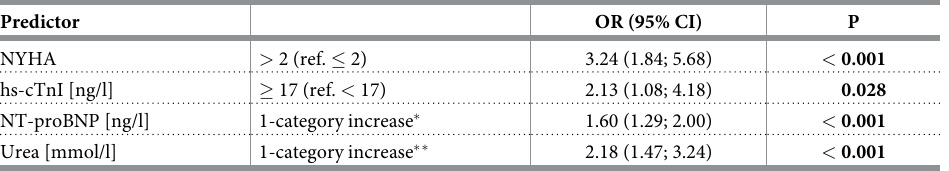
Table 4. The multivariable logistic regression model using a backward stepwise algorithm for the selection of independent predictors of the primary endpoint (i.e., the two-year prognosis in terms of all-cause mortality, heart transplantation and left ventricular assist device [LVAD]